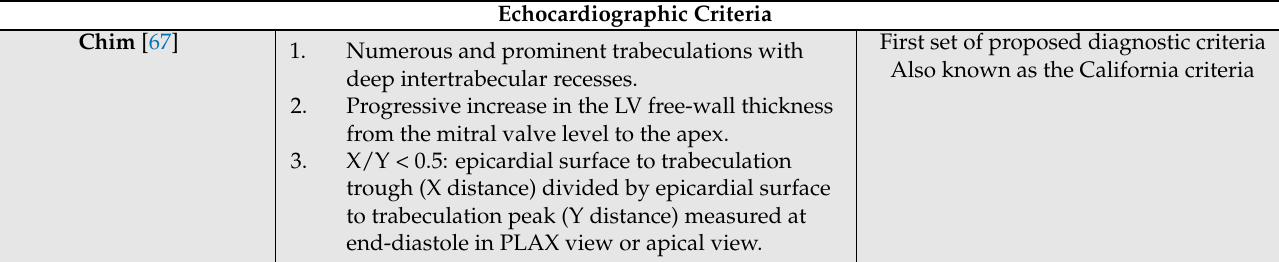
Table 1. LVNC diagnostic